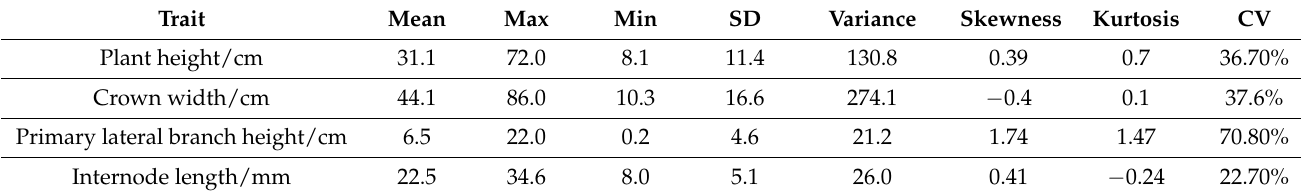
Table 1. Descriptive statistics of the four traits in the mapping population. Trait